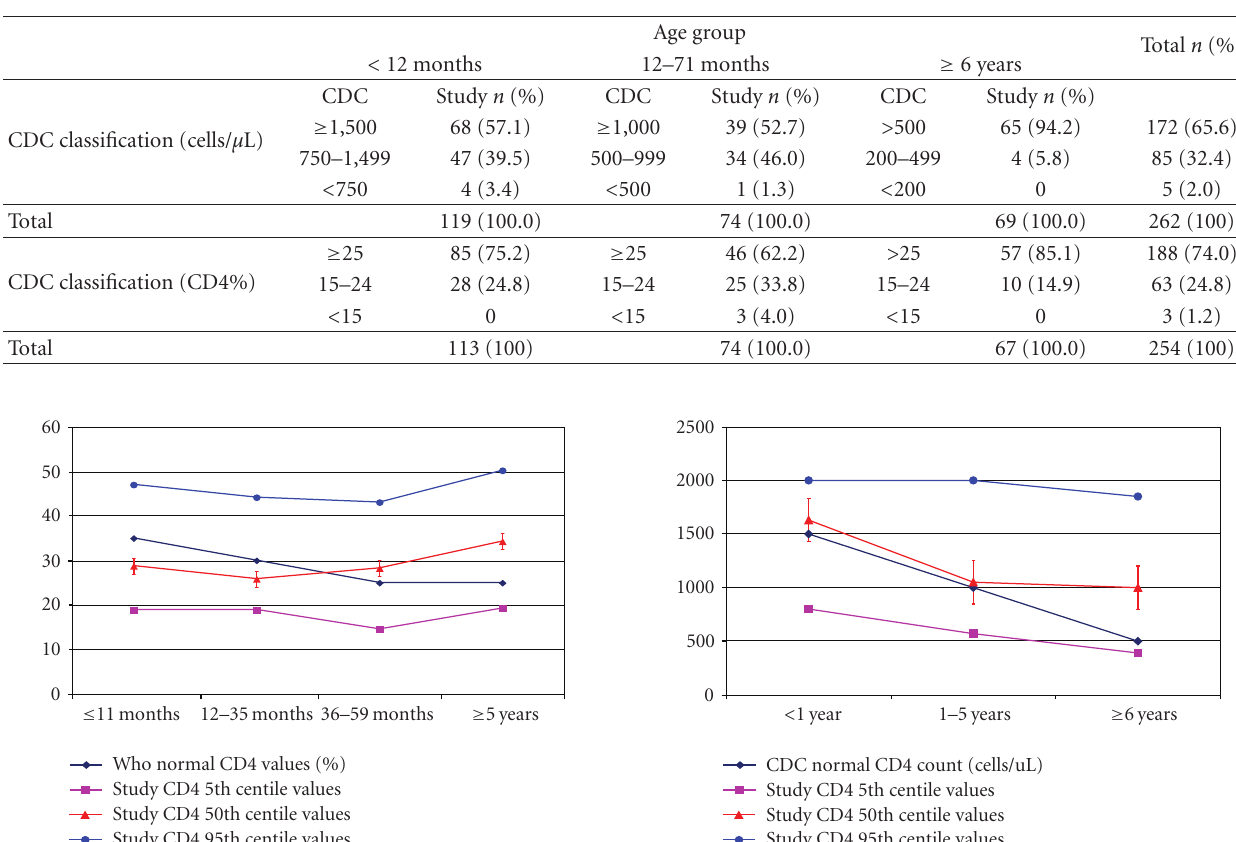
Table 4: Distribution of CD4 count by age group in study subject using CDC cut-o ff values.